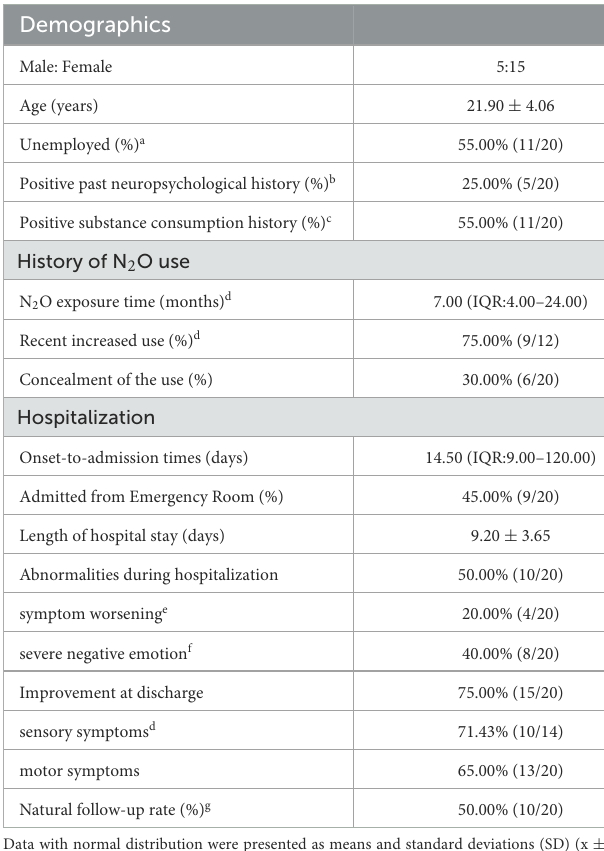
TABLE 1 Demographics, history of N 2 O use, and hospitalization of the